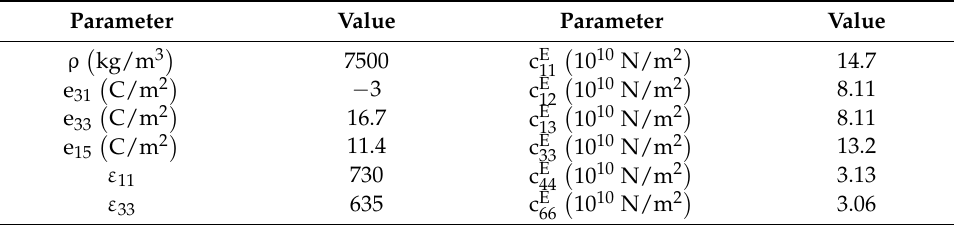
Table 1. Piezoelectric materials used for the PZFlex simulation.